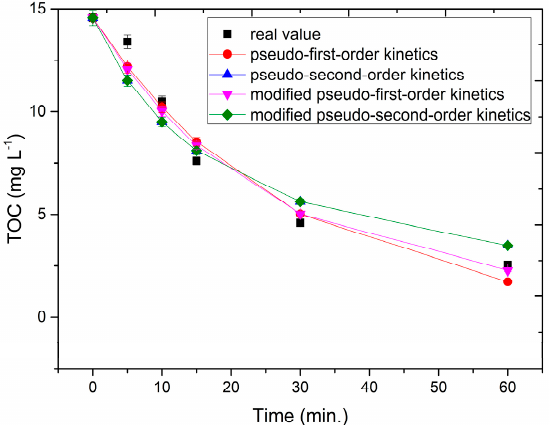
Figure 11. Kinetic model fitting for AM ACID, H 2 O 2 400 mg L − 1 , and ZVI 100 mg L − 1 .